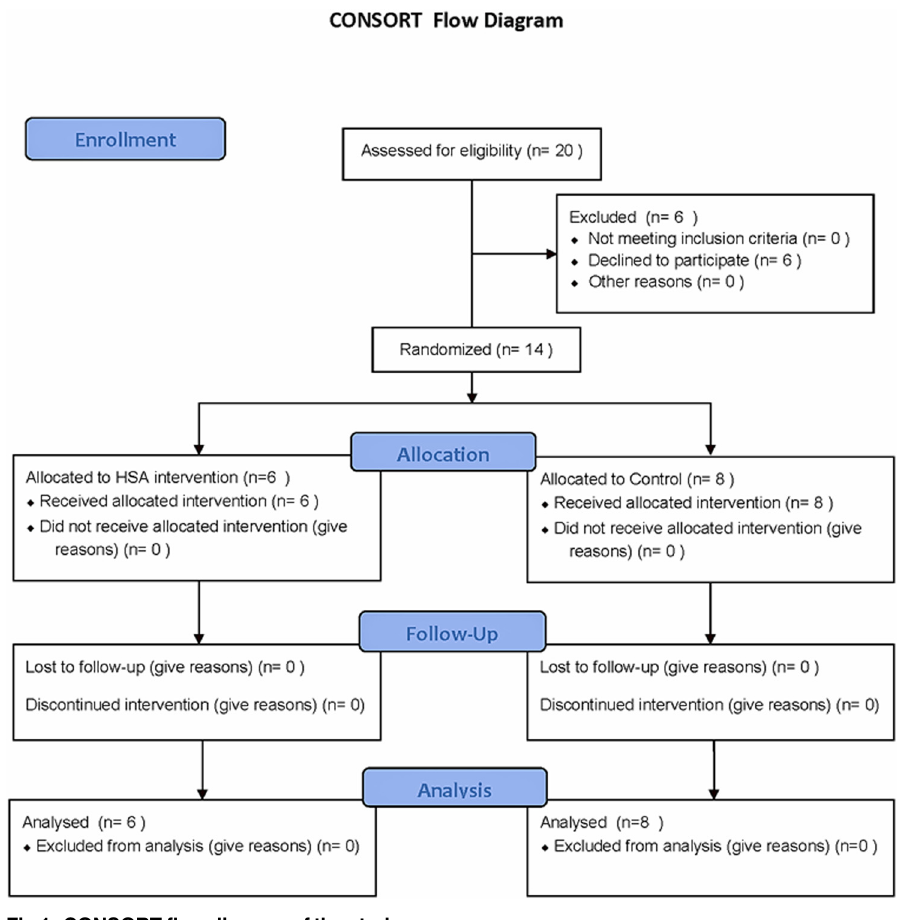
Fig 1. CONSORT flow diagram of the